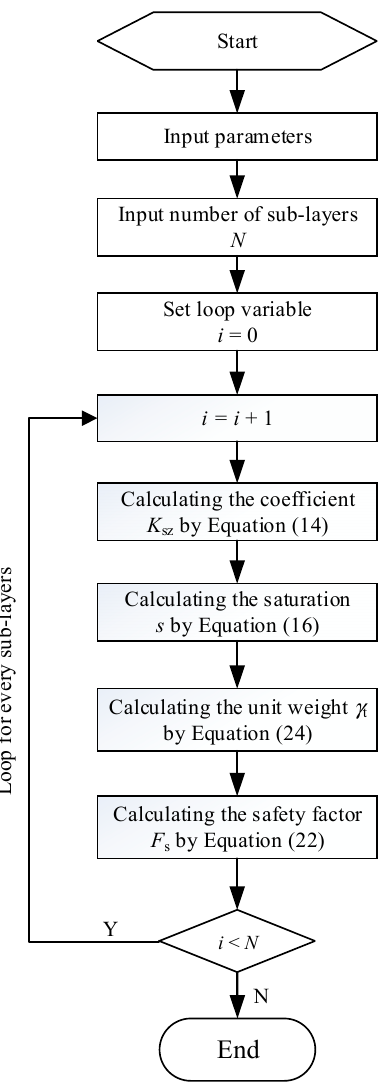
Figure 9. Flow chart for safety factor calculations.